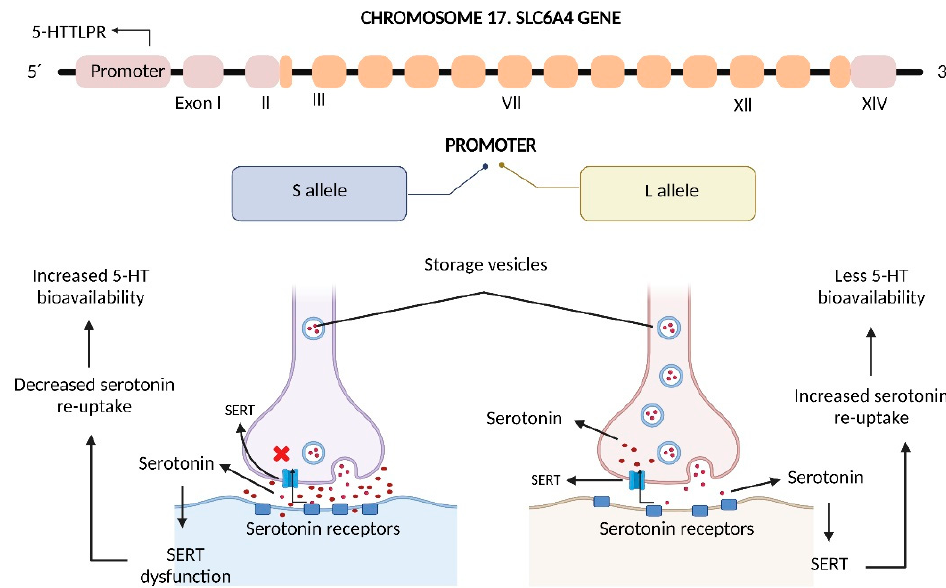
Figure 4. SLC6A4 gene and 5-HTTLPR act as regulators of serotonergic neurotransmission. The SLC6A4 gene possesses the 5-HTTLPR genetic variant with two alleles: a short allele (S; 486 bp) and a long allele (L; 530 bp). Both alleles have an influence on SERT functionality, where the S allele is related to lower serotonin re-uptake, leading to increased serotonin bioavailability, while the L allele endows pre-disposition to increased re-uptake by SERT. SERT, Serotonin Transporter; 5HT, 5-hy- droxytryptamine.